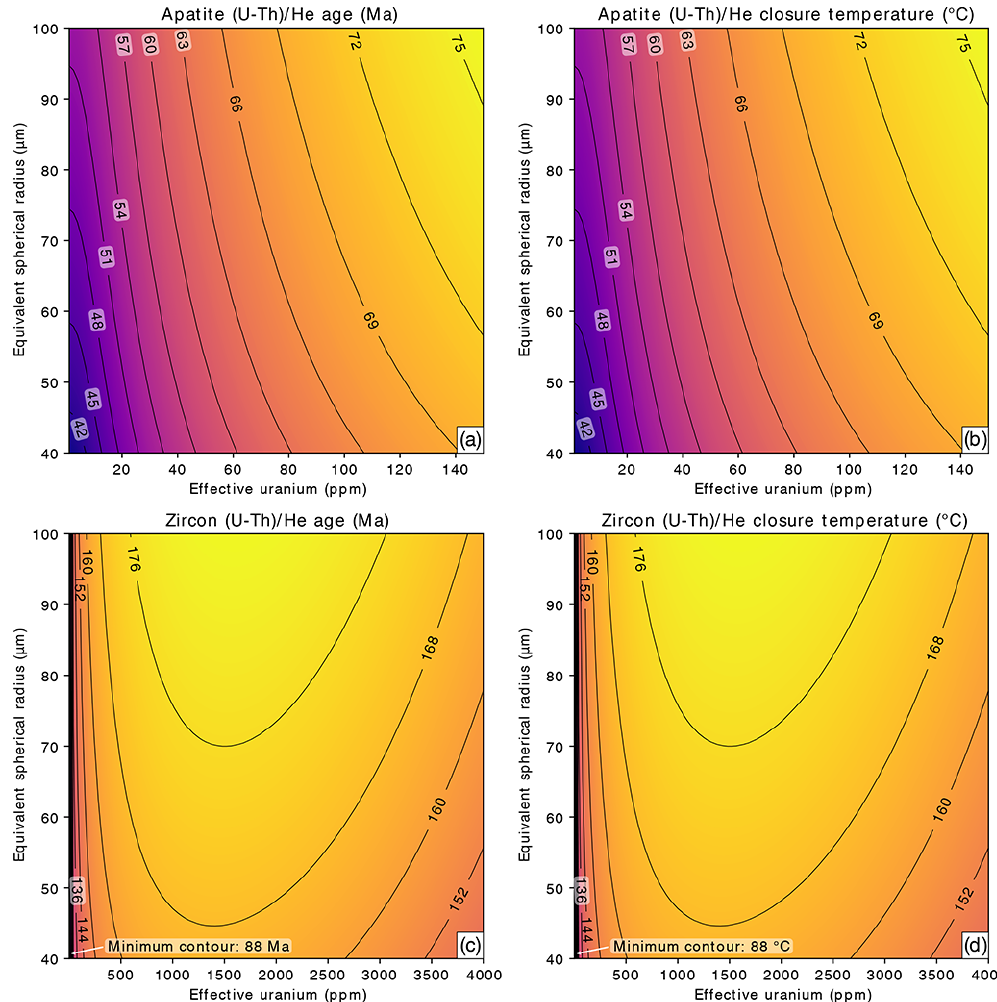
Figure 3. Contoured model (U-Th) / He cooling ages (a) and closure temperatures (b) for apatite and model (U-Th) / He cooling ages (c) and closure temperatures (d) for zircon of different effective spherical radii and eU concentrations (ppm). All panels are calculated for cooling from 350 to 0 ◦ C at a constant rate of 1 ◦ CMyr − 1 . Note that the similarities between the left and right columns are due to the ages and closure temperatures being expected to have the same value for a cooling rate of 1 ◦ CMyr − 1 . The plots comprise predicted ages and closure temperatures for 10201 forward